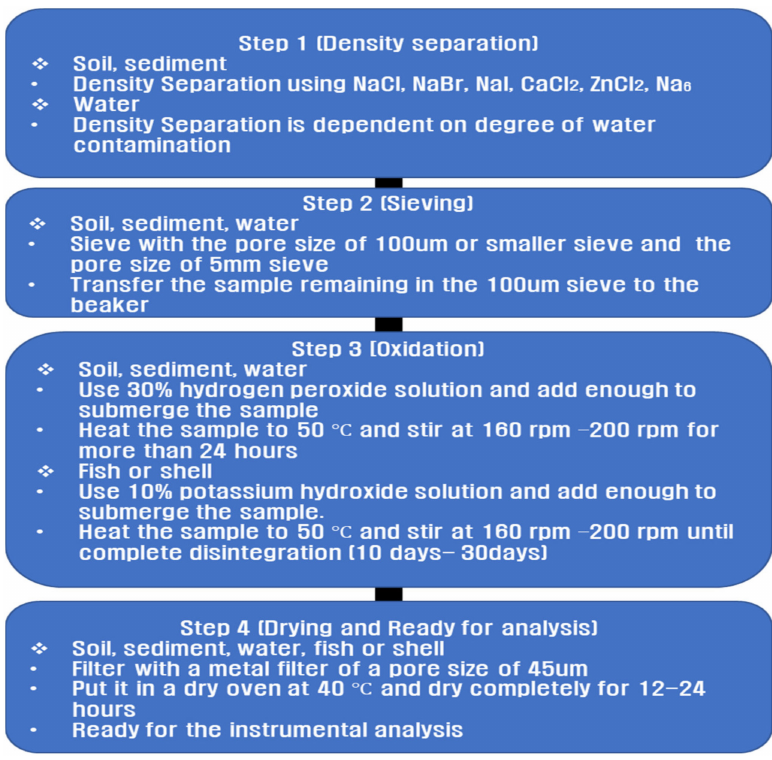
Figure 7. Simple pretreatment